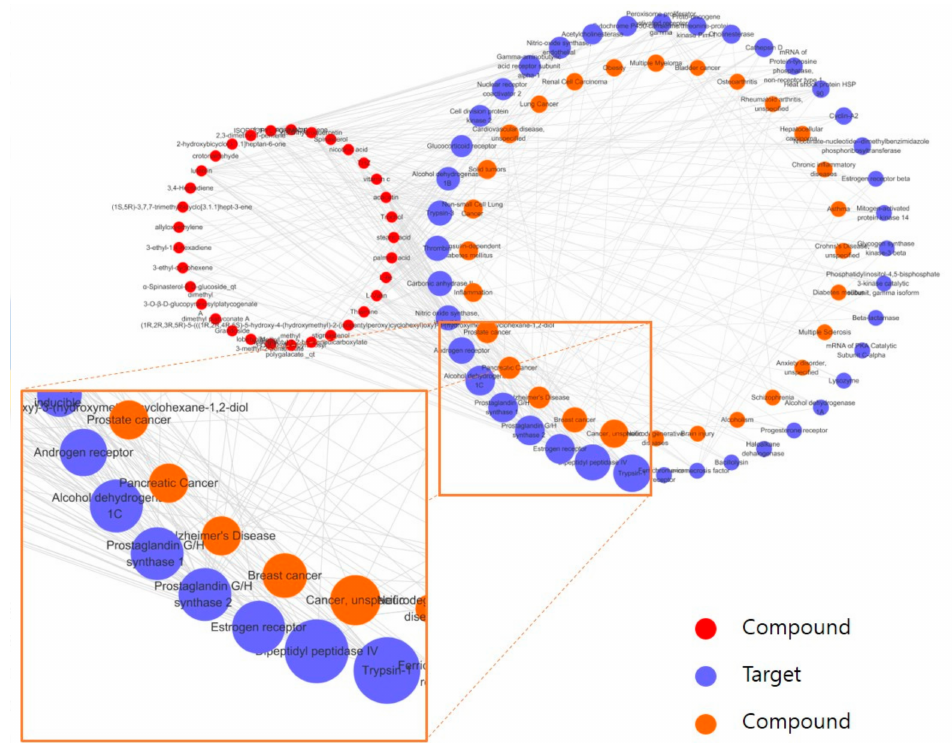
Figure 3. Compound–target–disease (CTD) network of PG. The red circles represent compounds, the purple circles represent targets, and the orange circles represent diseases. The compounds, targets, and diseases of each network are sorted in descending order from the bottom of the figure in a circular layout, on the basis of the number of degrees. The size of the target and disease nodes reflects the number of degrees. The node was removed when the number of degrees of the target and disease nodes was <3. The orange box represents the top five targets and diseases in terms of